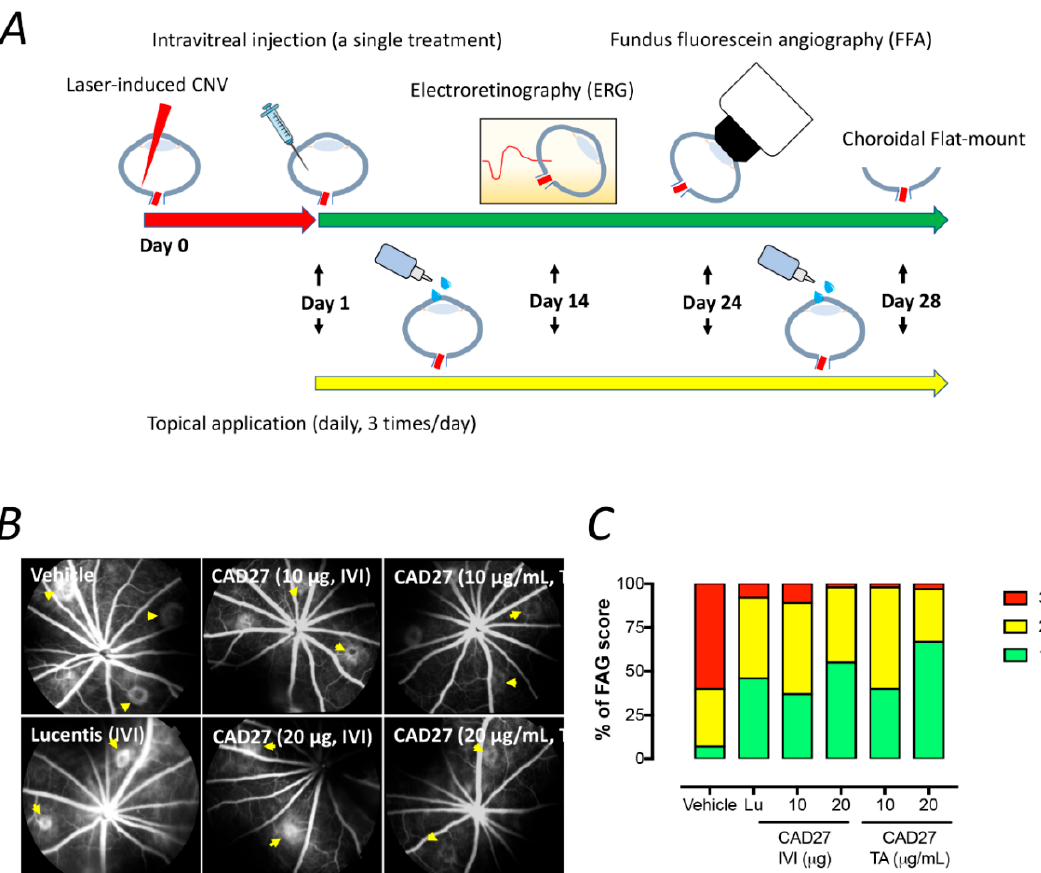
Figure 4. Fluorescein angiographic analysis of choroidal neovascularization (CNV) lesions after an intravitreal or daily topical application of CAD27. ( A ) A schematic diagram of the timeline for the laser-induced CNV rat model, treatments, and examination. Choroidal vascularity of laser-induced CNV lesions was examined by FFA (day 24) and choroidal flat-mount labeling with FITC-dextran (day 28) after a single intravitreal injection or daily topical application of CAD27. ( B ) Representative CNV lesions in rat eyes were identified by fundus fluorescein angiography after an intravitreal or daily topical application of CAD27. Yellow arrows indicated the lesions of CNV. ( C ) CNV lesions from fluorescein angiography were analyzed at days 24 after treatment, and data are presented as percentage of CNV score ( n = 26–46 from 6 to 8 eyes). Score 1 (green) indicates staining, Score 2 (yellow) indicates moderate leakage, and Score 3 (red) indicates heavy leakage. Lu: Lucentis ® , IVI: intravitreal injection, TA: topical application.